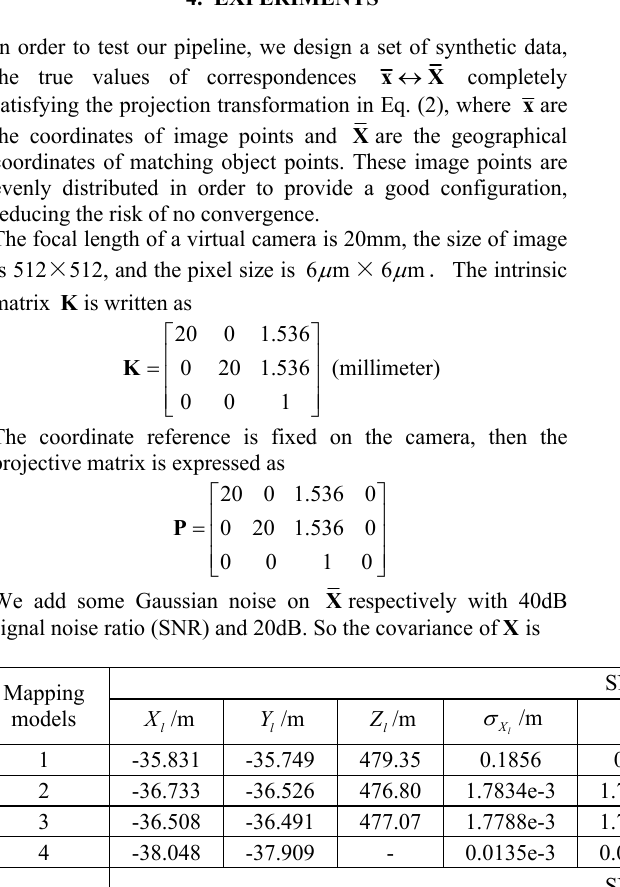
This contribution has been